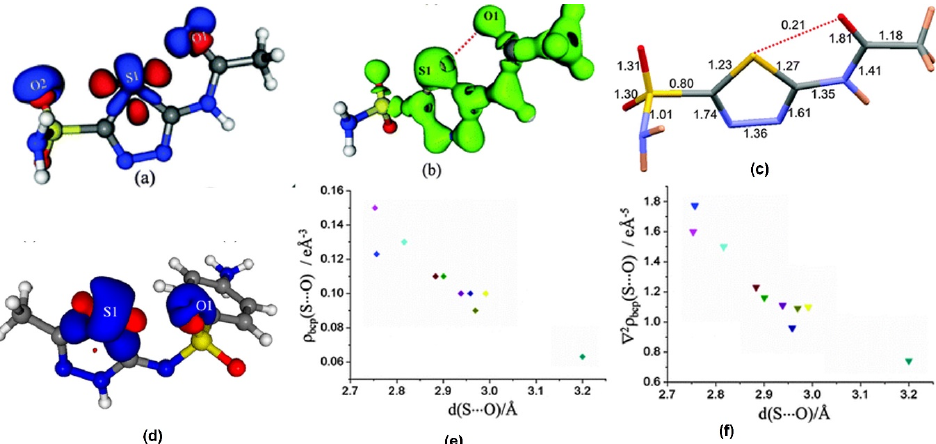
Figure 8. ( a , d ) The 3D deformation density maps reveal the CD ··· CC nature of intramolecular S ··· O ChBs in acetazolamide and sulfamethizole, respectively. ( b ) Laplacian isosurface showing the rest of captionfeatures corresponding to sigma-holes around S atoms, ( c ) bond orders corresponding to different bonds, and S ··· O chalcogen bond in acetazolamide . ( e , f ) electron density and Laplacian at the BCPs of intramolecular S ··· O chalcogen bonds derived from experimental charge density models reported in the literature. (Figures reproduced from references